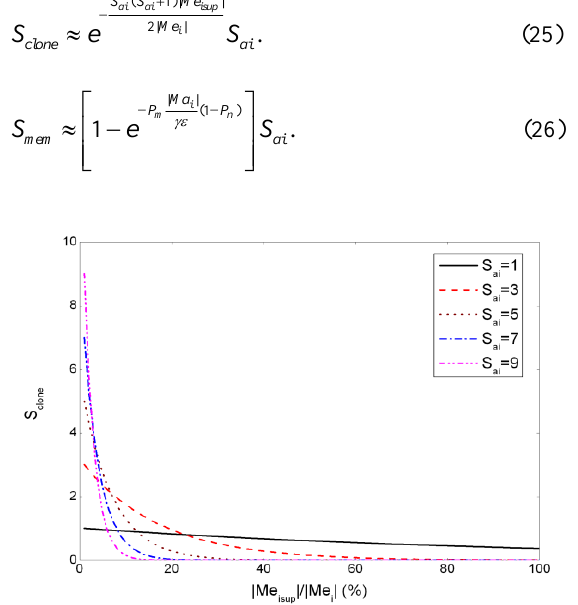
Fig. 3. The effect of S ai on S clone .